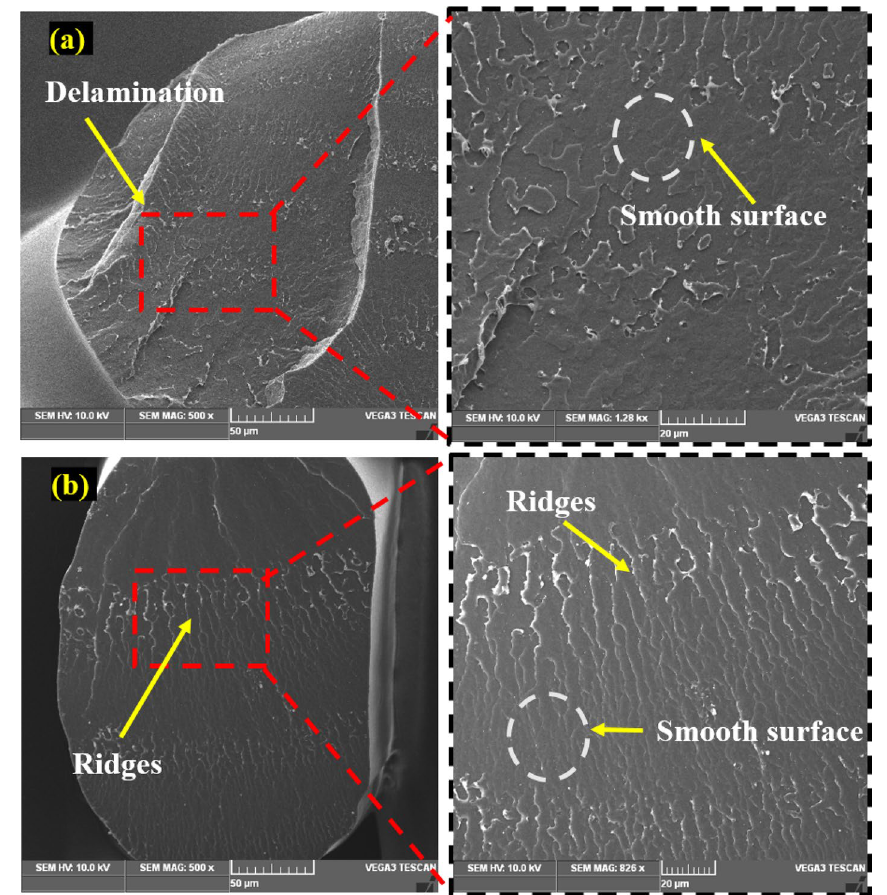
Figure 9. Microstructural analysis of the flexural specimens ( a - b ) fracture surface under optimum input